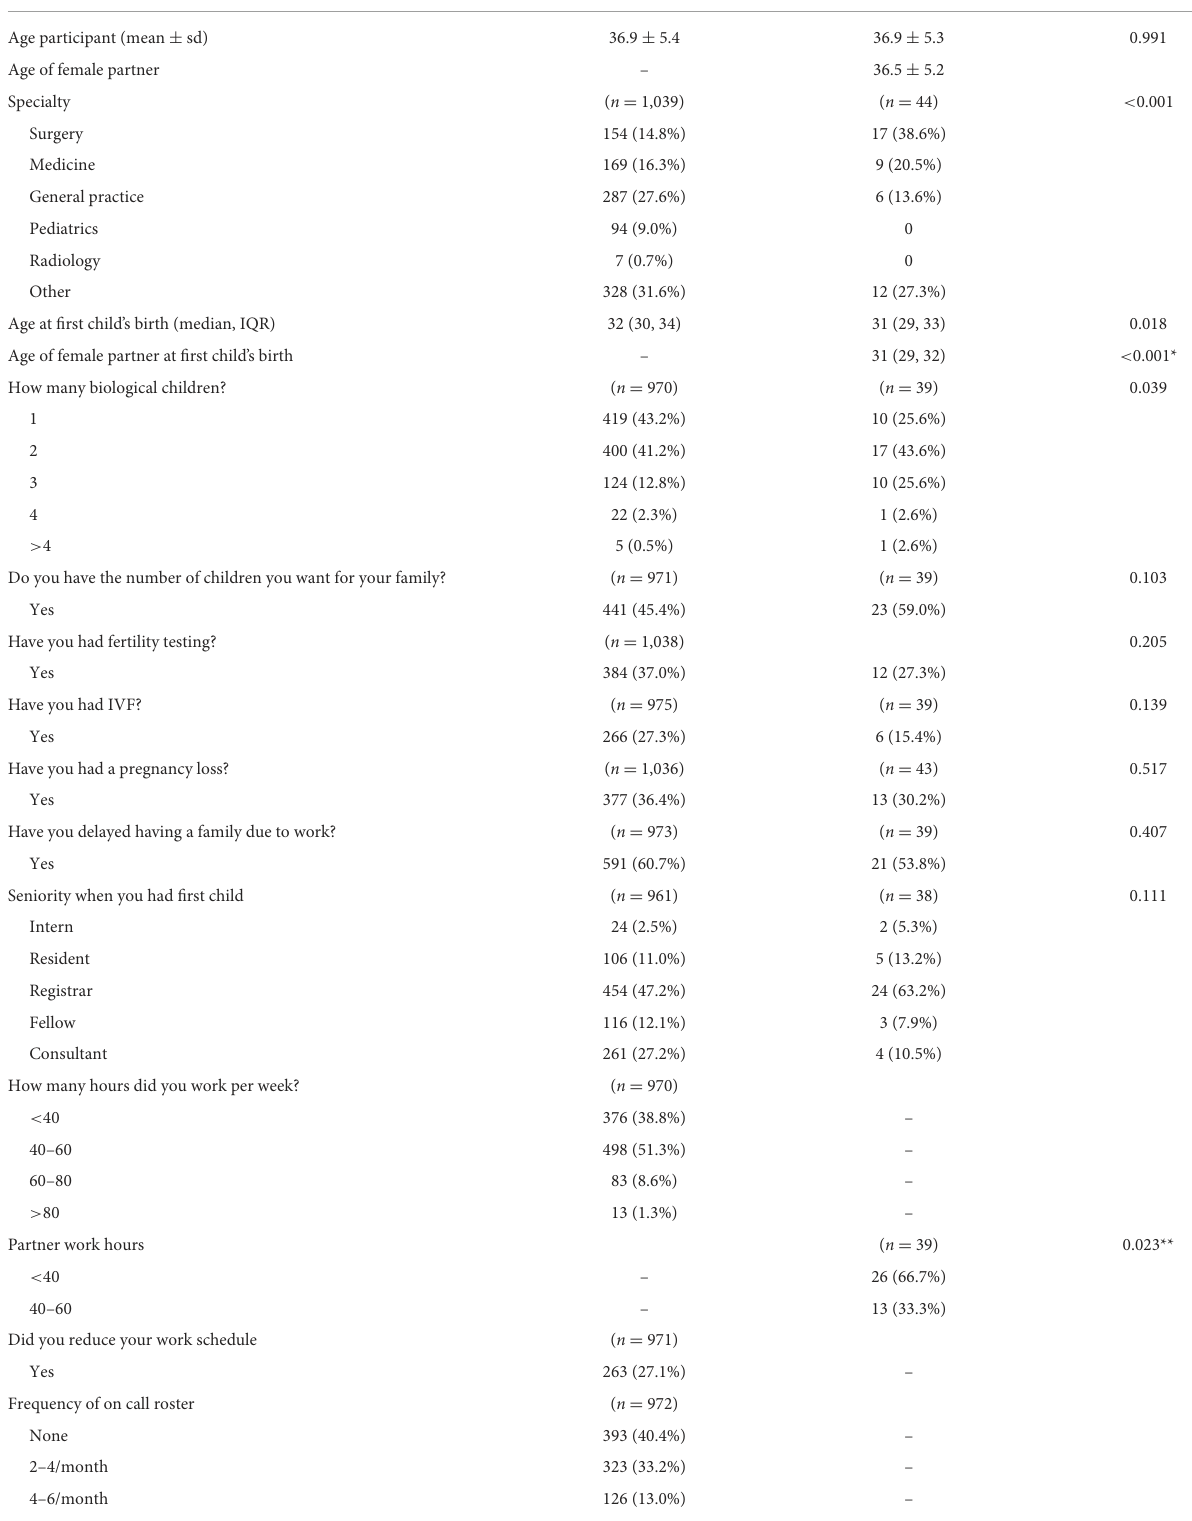
TABLE 1 Comparison between female and male